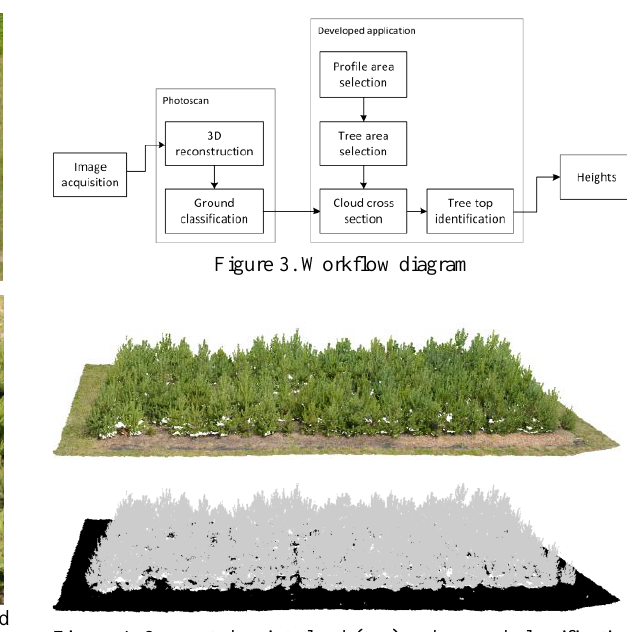
Figure 4. Generated point cloud (top) and ground classification